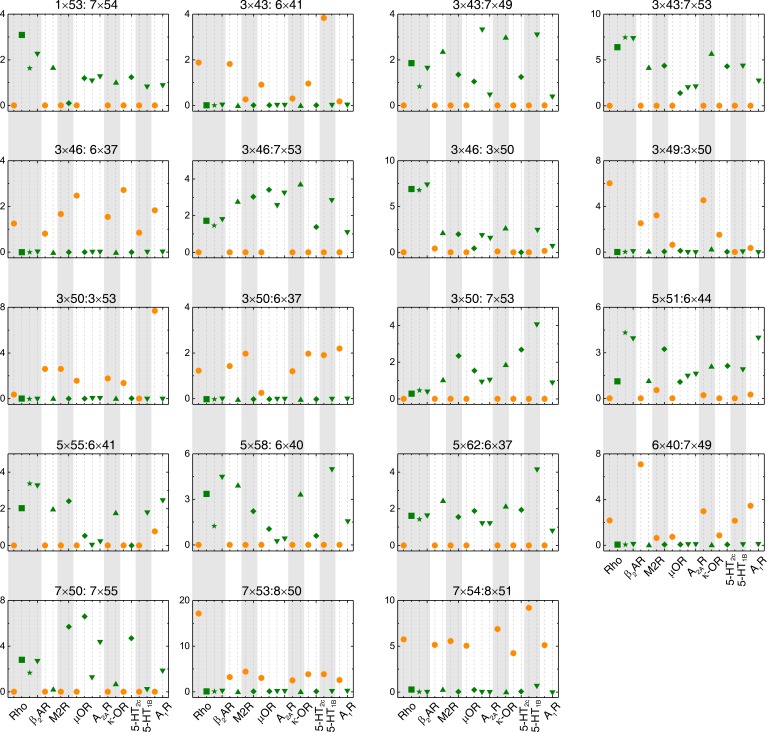
The switching conformation change is conserved upon receptor activation.Comparison of RRCS for active (green) and inactive (orange) states of eight receptors with different intracellular binding partners, including four recently solved cryo-EM structures of Gi/o-bound receptors (5-HT1B receptor, rhodopsin, A1R and µOR) whose resolutions were low (usually ≥3.8 Å for the GPCR part). Nevertheless, almost all conserved residue rearrangements in the pathway can be observed from them. Nineteen of 34 residues pairs were shown here, see Figure 4 and Figure 4—figure supplement 2 for the remaining residue pairs.